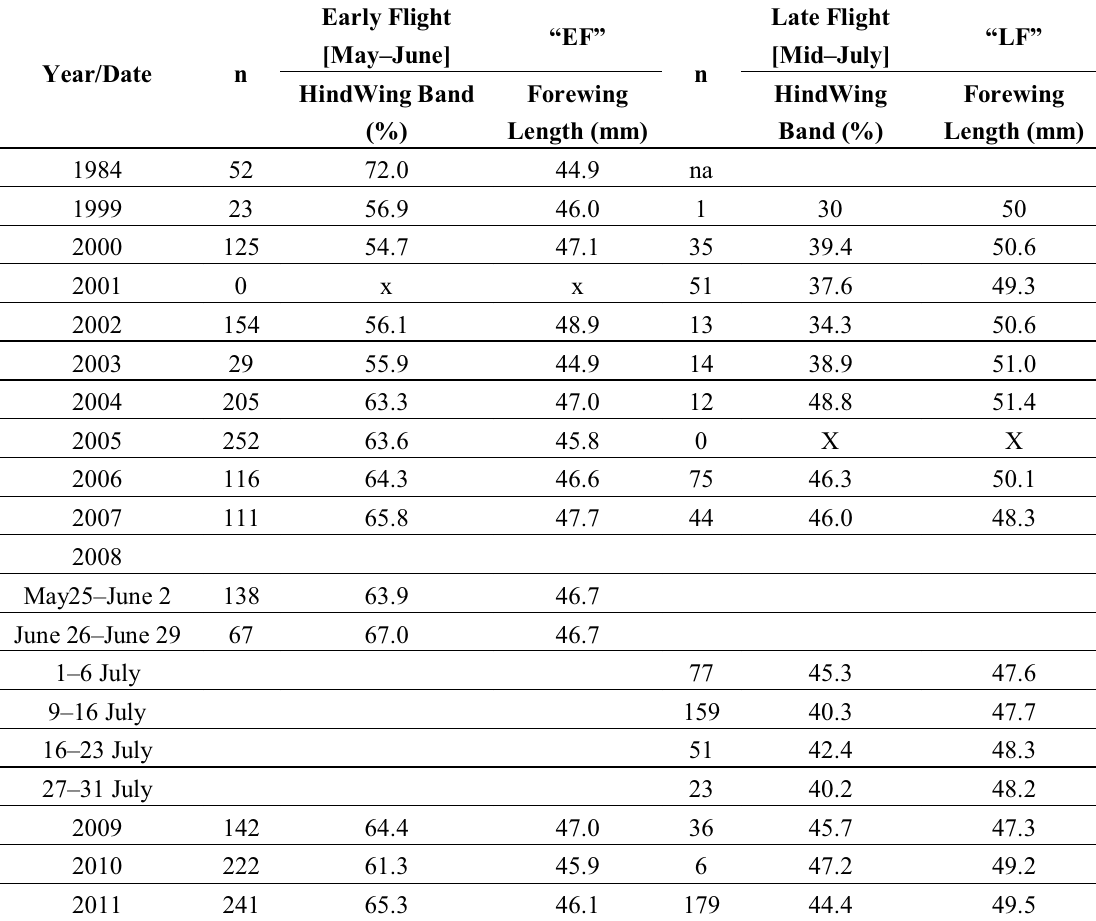
Table 2. Mean hindwing band widths and forewing lengths of Papilio males collected in the Battenkill River area of western Vermont (Bennington County) and adjacent (Cambridge, New York, in Washington